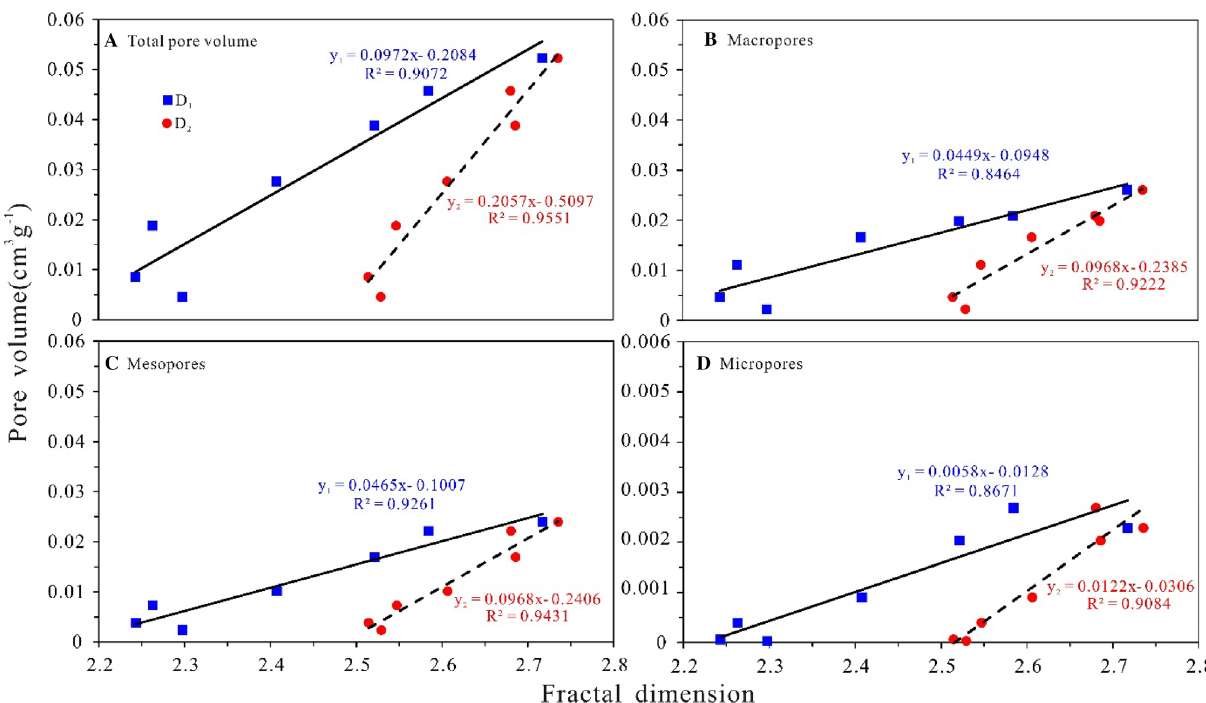
Fig. 5 Relationships between fractal dimensions and pore volumes in pyrolyzed oil shales